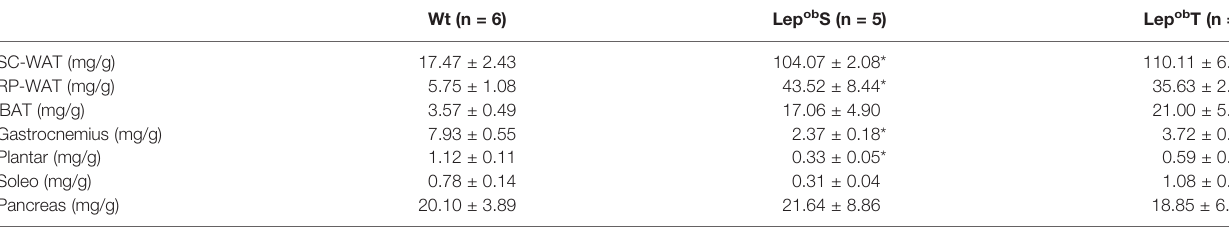
TABLE 1 | The weight of adipose tissue, skeletal muscles, and pancreas.